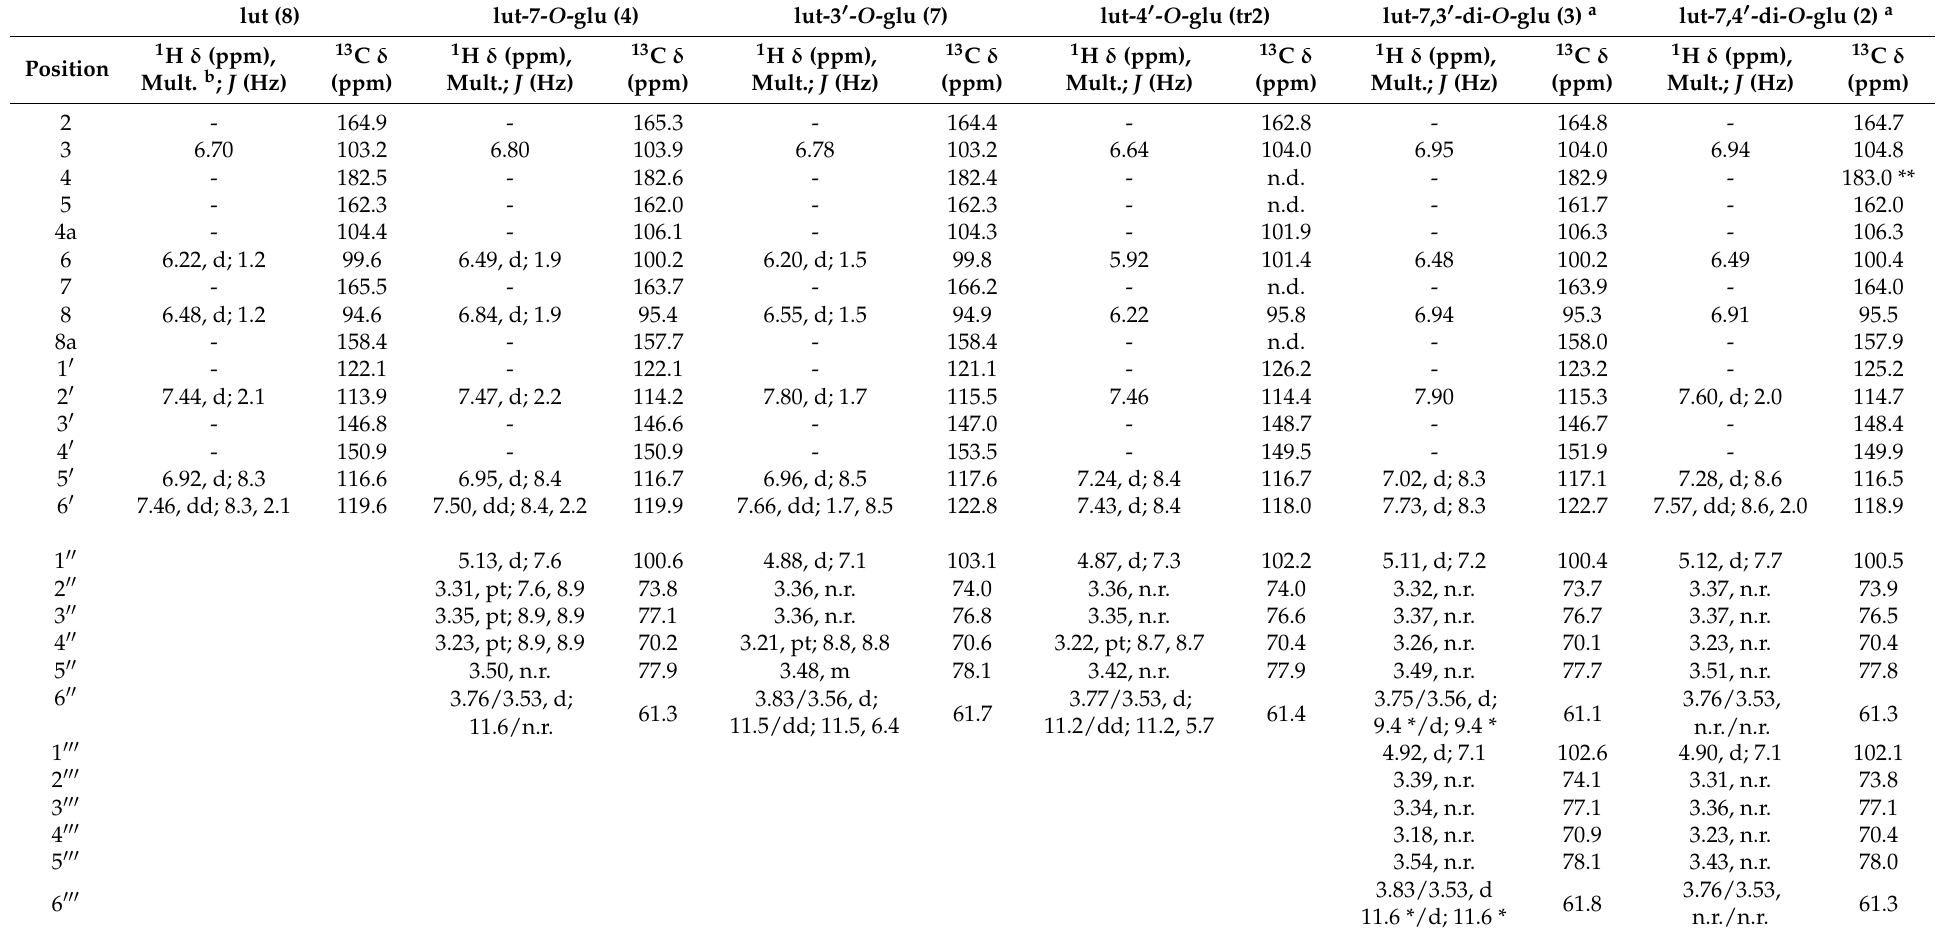
Table 1. 1 H-NMR and 13 C-NMR data of weld flavones; numbering of compounds as in Figure 1 (DMSO- d 6 , 300